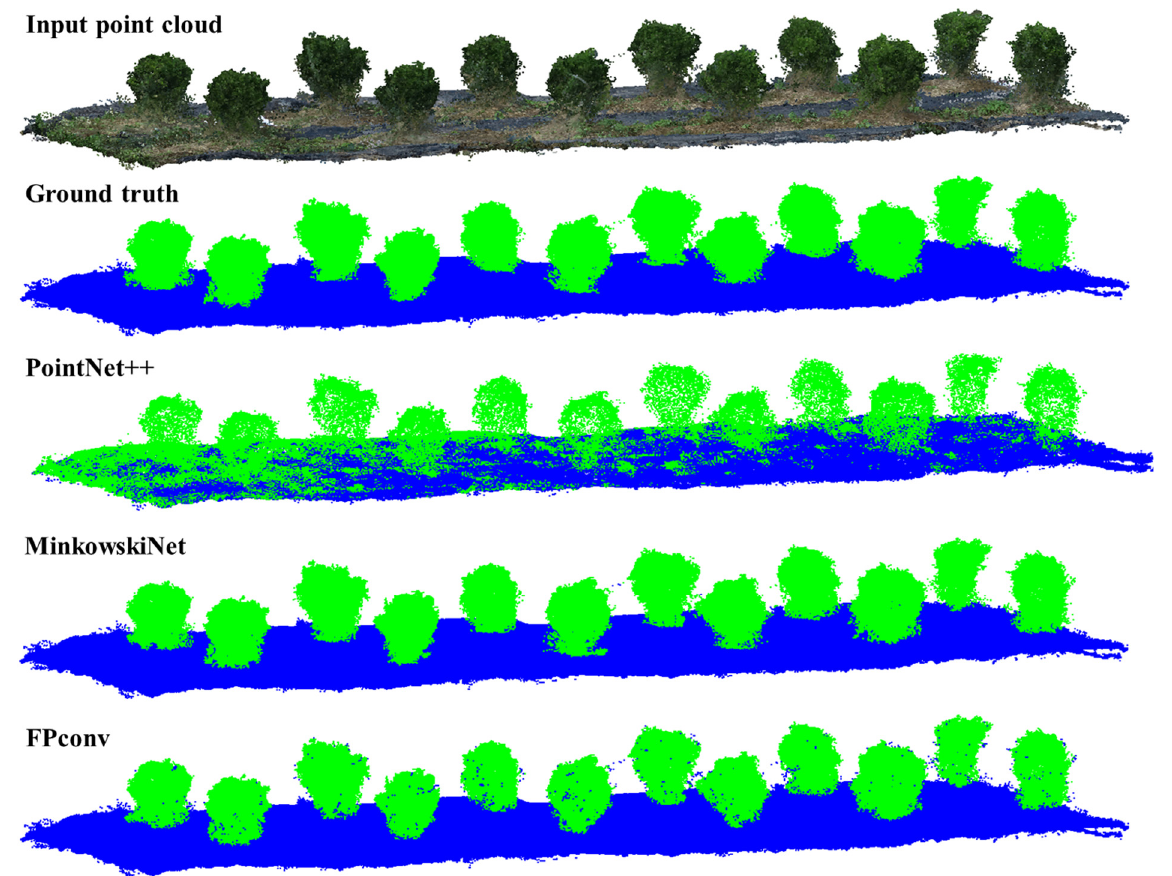
Figure 12. Semantic segmentation results for the orchard dataset.